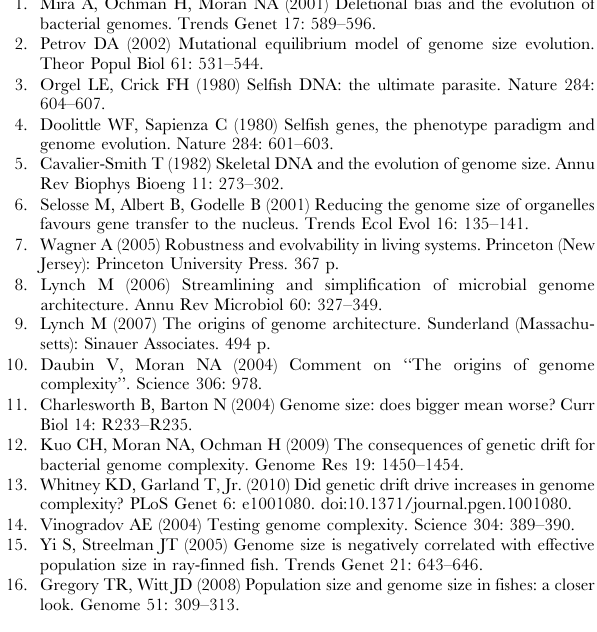
recombinant products associated with this repeat pair is approx- imately 2%. Figure S5 Relationship between length and sequence identity for repeats in S. noctiflora (top) and S. conica (bottom) mtDNA. Each point represents a single pair of repeated sequences identified by BLAST, with the x -axis showing the aligned length of those sequences and the y -axis describing the extent of sequence similarity between the pair. Note that, in contrast to the large number of imperfect repeats (sequence identity , 100%) in S. noctiflora and S. conica , all S. latifolia and S. vulgaris repeats in this size range are 100% identical or nearly so (Figure 7). Figure S6 Assays of repeat-mediated recombinational activity in Silene mitochondrial genomes. (A) The left column shows the data presented in Figure 6 individually for each species (note the change in scale for each species). (B) The right column reports the analysis of the exact same repeats except in reversed orientation as a measure of the baseline level of alternative genome conformations and/or library construction artifacts in each species. Note that not all repeat pairs are shown (see Materials and Methods for filtering criteria).